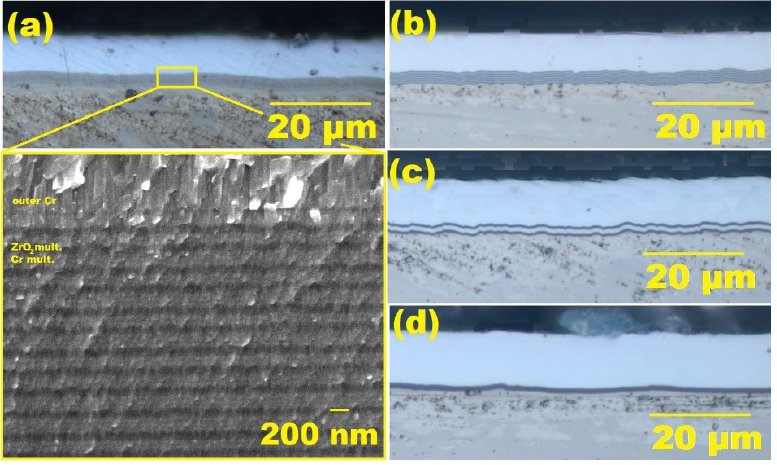
Figure 1. Optical images of the cross-section microstructure of the E110 alloy samples with ( a ) ZrO 2 /Cr-100, ( b ) ZrO 2 /Cr-250, ( c ) ZrO 2 /Cr-750, and ( d ) ZrO 2 /Cr coatings. Cross-section SEM image of a barrier layer of the ZrO 2 /Cr-100 sample is added.